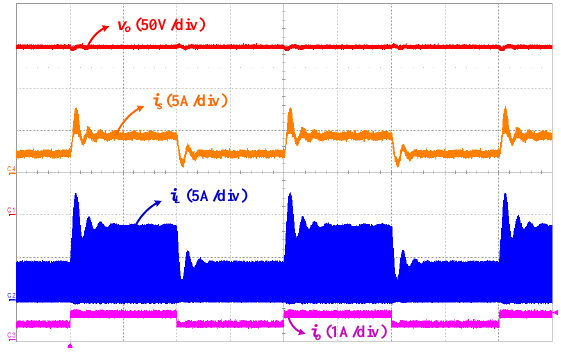
Figure 14. The measured waveforms of the proposed converter under dynamic load change (100 ms/div).